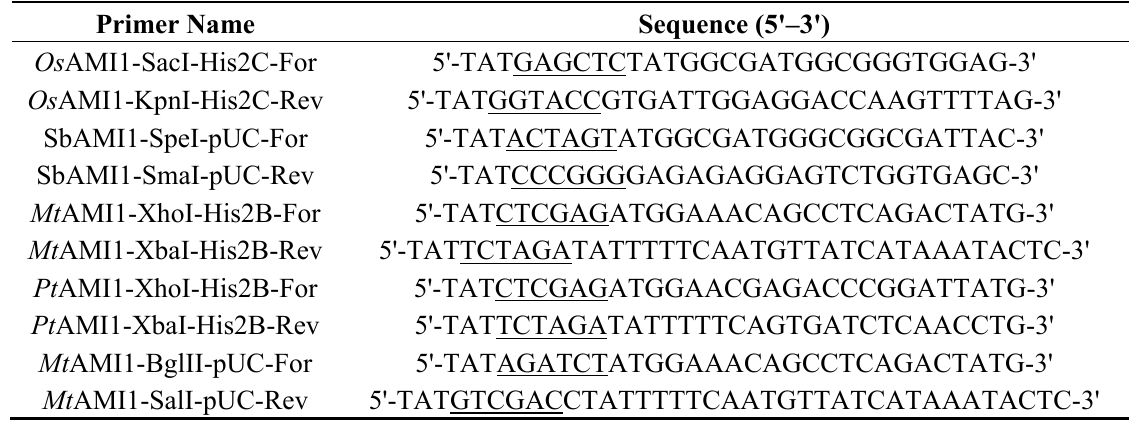
Table 3. Primers used for cloning of the described